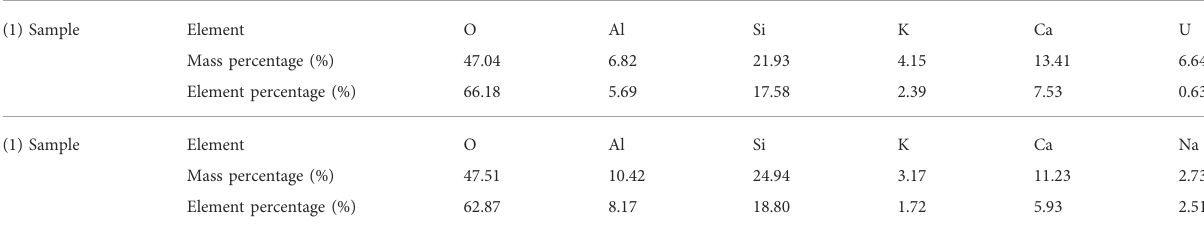
TABLE 3 EDS scanning results of uranium